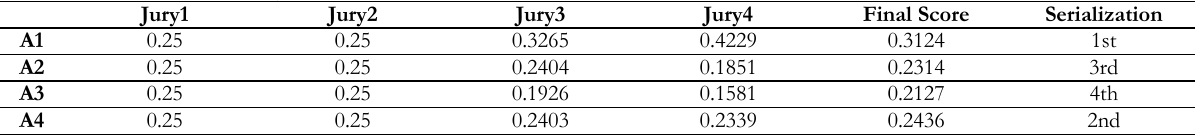
Table 5. Evaluation of all jury